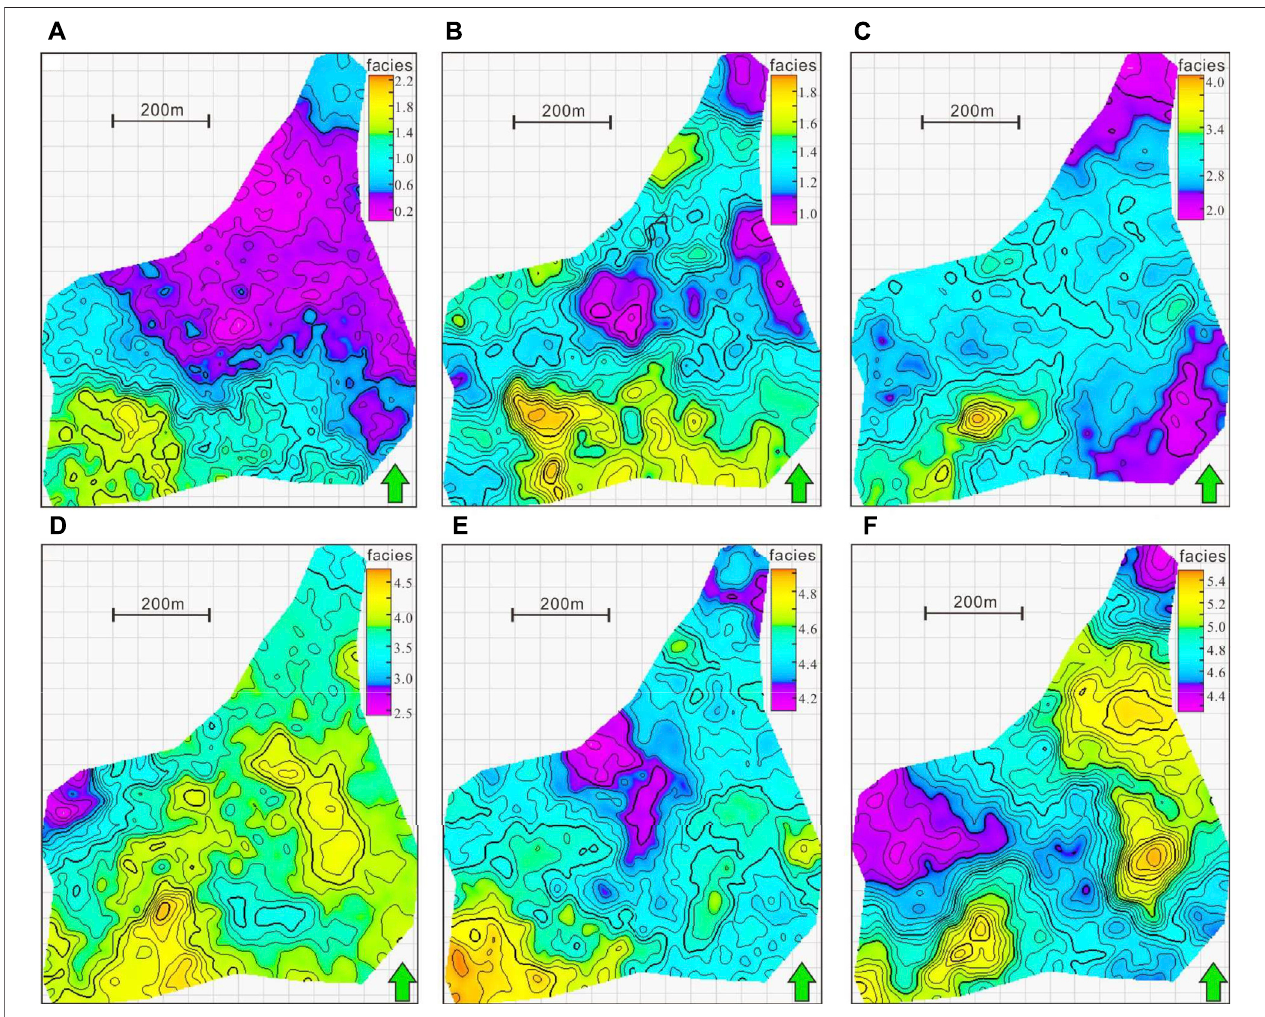
FIGURE 10 | Pattern of lithological distribution realized by the fi rst SIS modeling. (A – B) local point-like distribution reef limestone; (C) rich algal reef limestone; (D) high content locally; (E) point-like distribution in the northwest; (F) point-like distribution in the southwest.